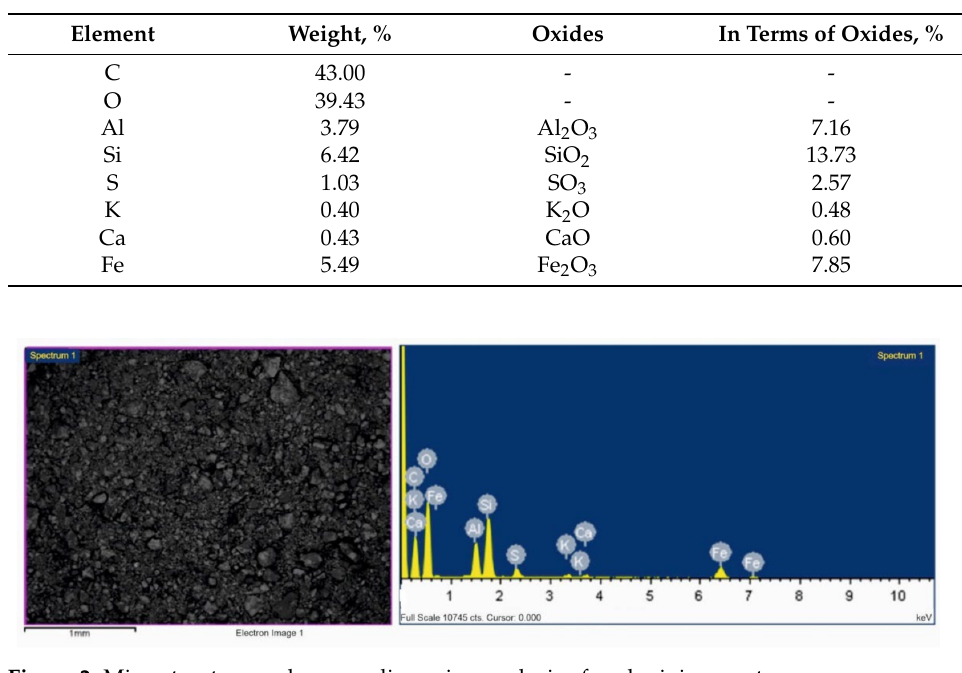
Figure 2. Microstructure and energy dispersion analysis of coal mining waste. According to the above data, the main part of coal mining waste is carbon, as well as substances such as sulfur, aluminum and silicon oxides. Potassium and calcium com- pounds are also present in small amounts.While in the microstructure of the obtained sample, minerals of sulfur, iron and calcium compounds are represented by whole clusters, minerals in the form of a small hexagonal crystal prove the presence of calcium aluminates. The silicon-containing compounds in the test sample are described by fine-type chain compounds [23].